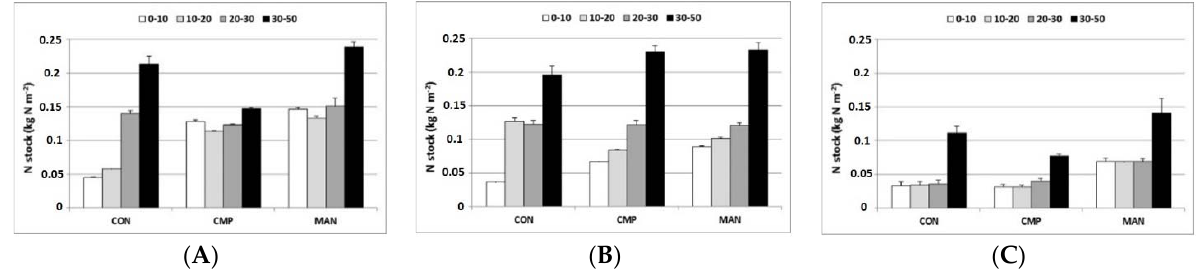
Figure 3. Change in N stocks over 8 years under the different treatments. (( A – C ) are respectively N stocks in 2013, 2016, and